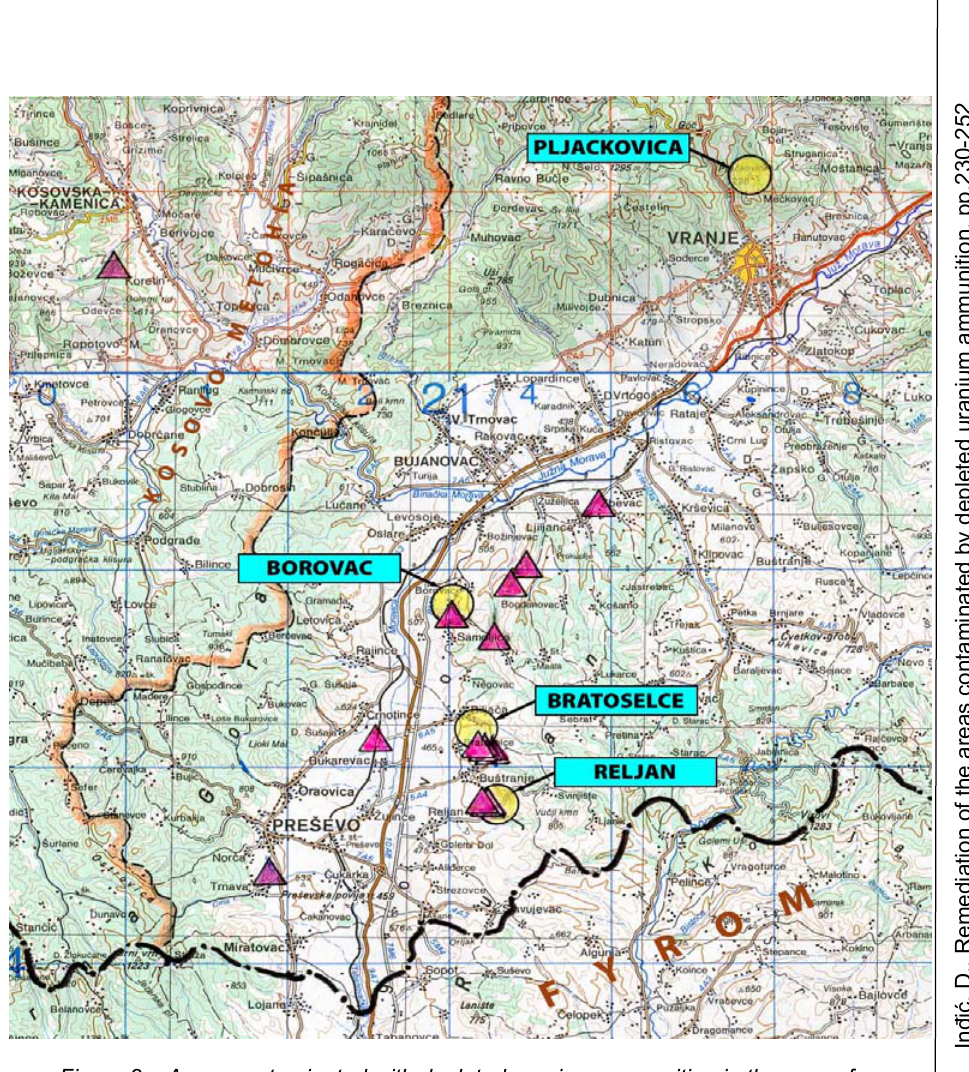
Figure 2 – Areas contaminated with depleted uranium ammunition in the area of R. Serbia (without AP Kosovo and Metohija) during the 1999 NATO aggression Рисунок 2 – _ Зоны , пораженные боеприпасами с обедненным ураном в районе Р . Сербия ( без АК Косово и Метохия ) во время агрессии НАТО в 1999 г . Слика 2 – Рејони контаминирани муницијом са осиромашеним уранијумом на подручју Р . Србије ( без АП КиМ ) током НАТО агресије 1999.